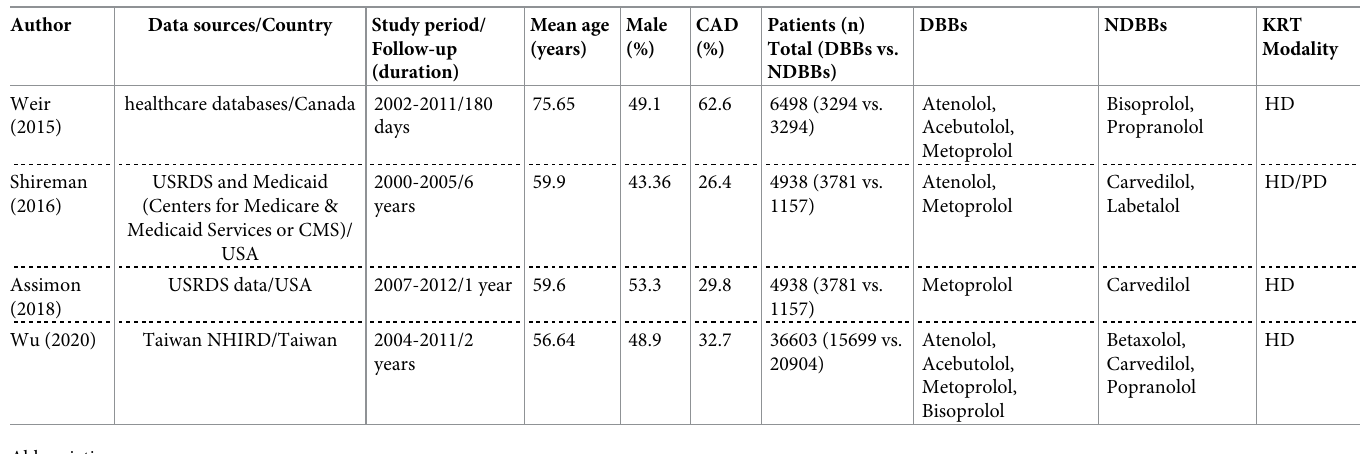
Table 1. Summary of the baseline characteristics of the included studies (n =